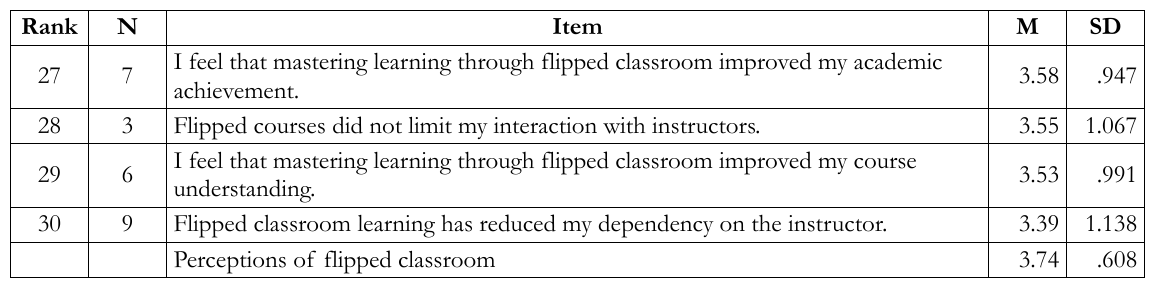
Table 2. Means and standard deviations of the students’ perceptions of flipped